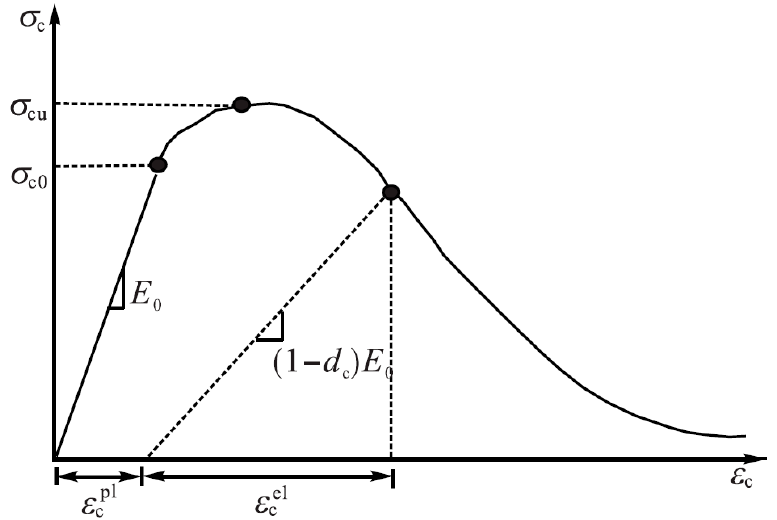
Figure 2. Schematic diagram of the CDP model (image used with the permission of publisher) [39]. To simulate the inelastic behavior of concrete, the damaged plasticity model for concrete combines the ideas of isotropic damaged elasticity with isotropic tensile and compressive plasticity. The concrete damage model is a continuous, plasticity-based model. The model is intended for applications in which low confining pressures and monotonic, cyclic, and dynamic stresses are applied to the concrete. This model decomposes the total strain ε into elastic ε el and plastic strains ε pl as